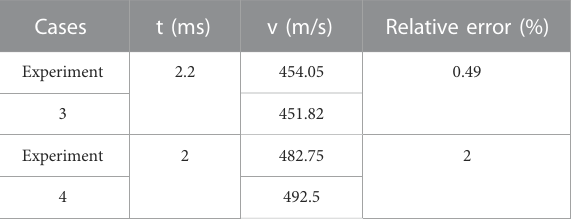
TABLE 2 Results of the experiment and simulation with the compression- driven method.